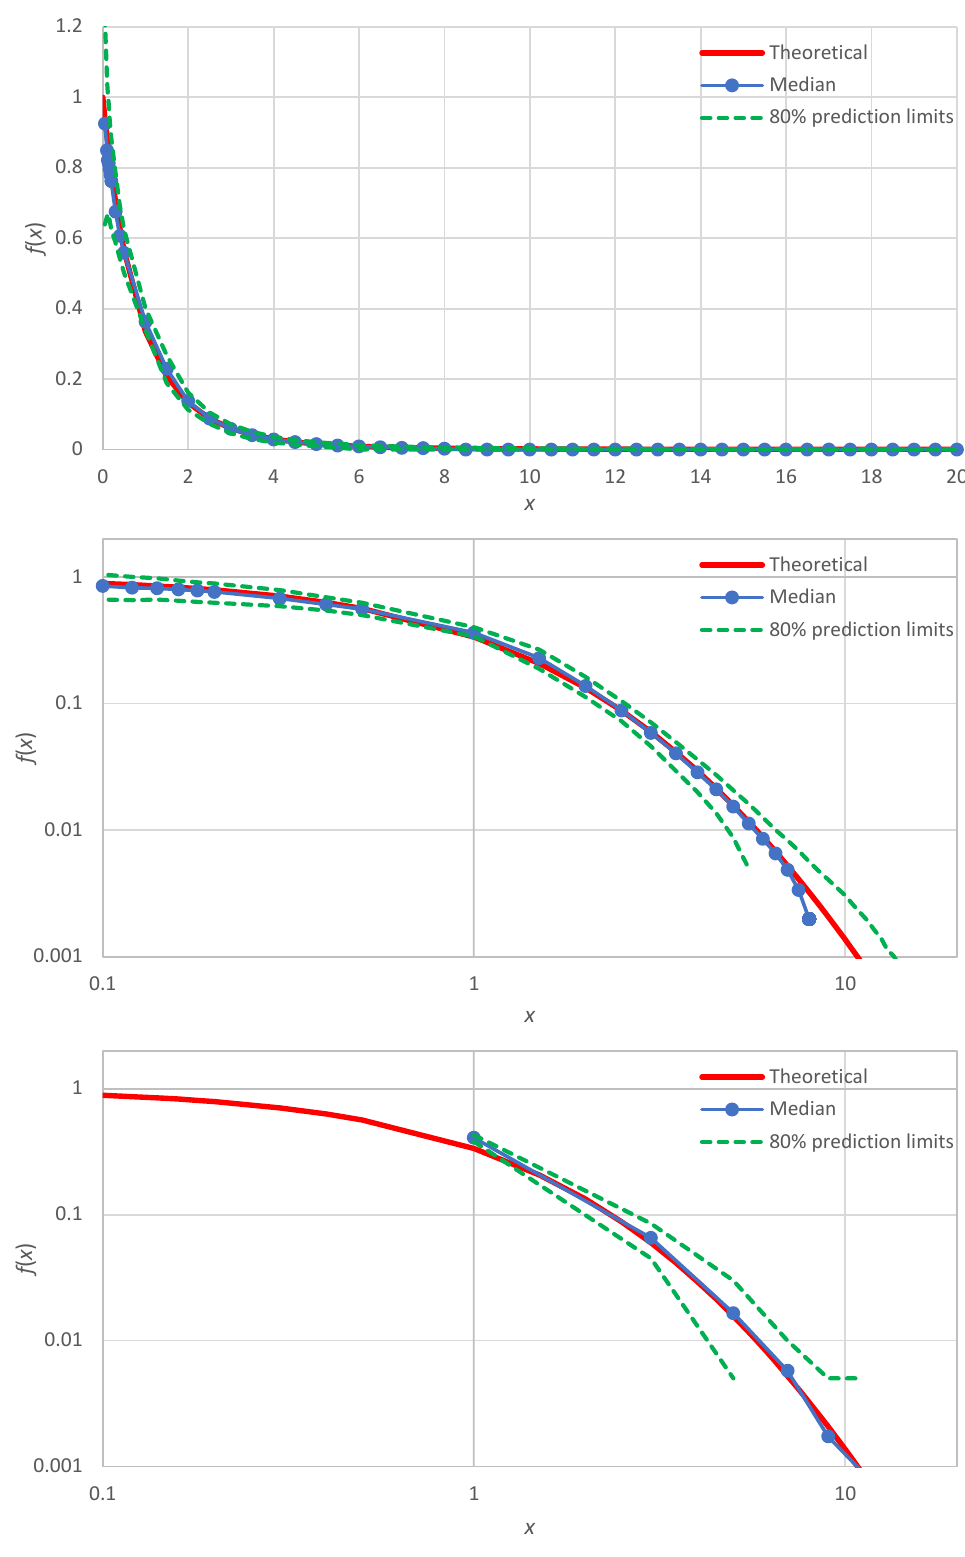
Figure 5. Illustration of the median estimate and uncertainty (in terms of prediction limits) of the probability density as in Figure 2 but for the Pareto distribution with parameters as in Table 4.